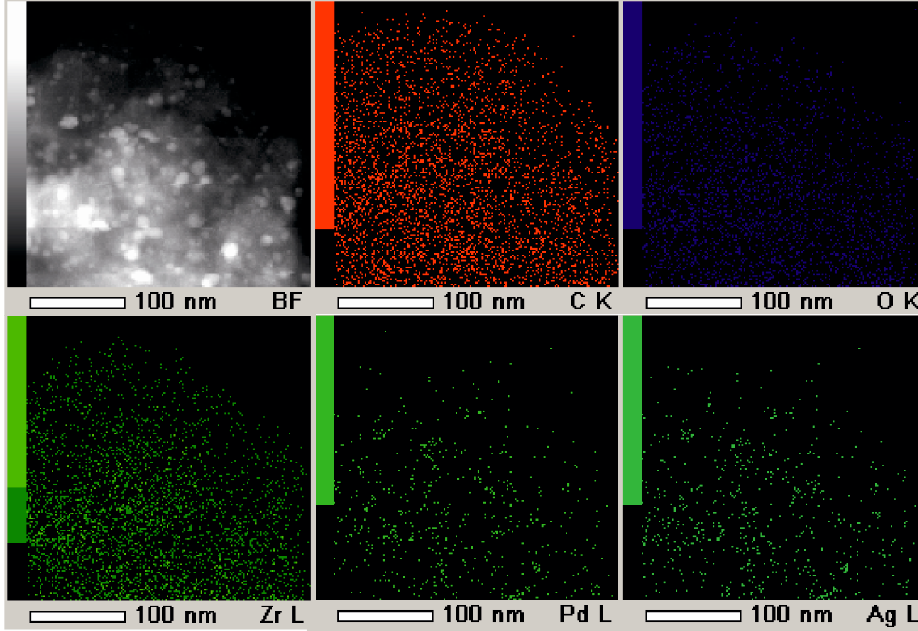
Figure 9. Energy-dispersive spectroscopy (EDS) images (map) of 5% AgPd@UiO-66 with a Ag / Pd molar ratio of 1 / 1.